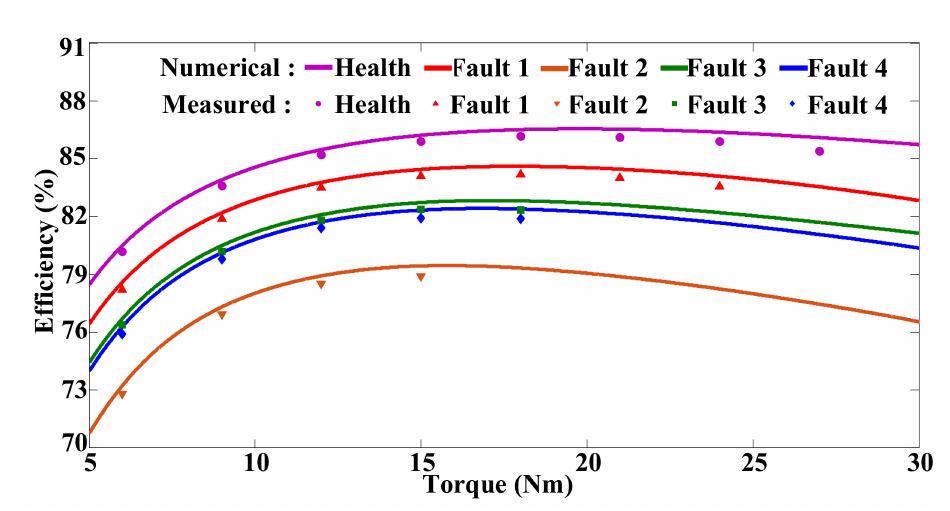
Figure 15. Comparation of the numerical and measured results for efficiency varying with torque.